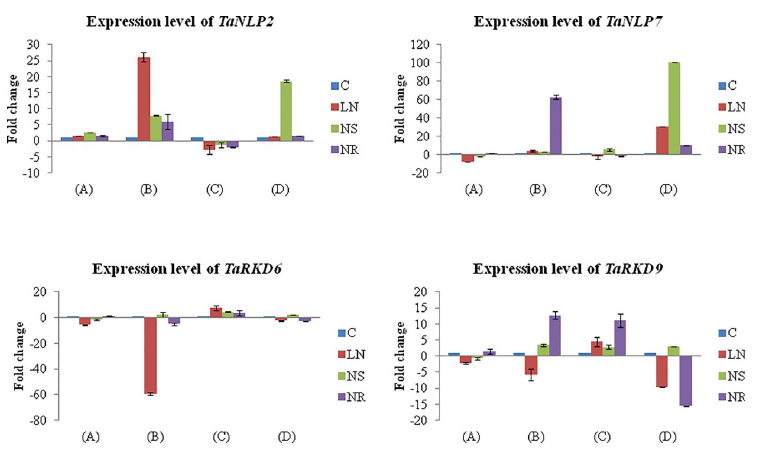
Fig 9. Relative expression level of two TaNLP and two TaRKD genes in root and shoot tissues of wheat seedlings. (A) C306 root, (B) C306 shoot, (C) HUW 468 root, and (D) HUW 468 shoot. Four treatments are shown by four different colours. For details of treatments, see text. C-control, LN- low N, NS- N starvation and NR- N restoration.